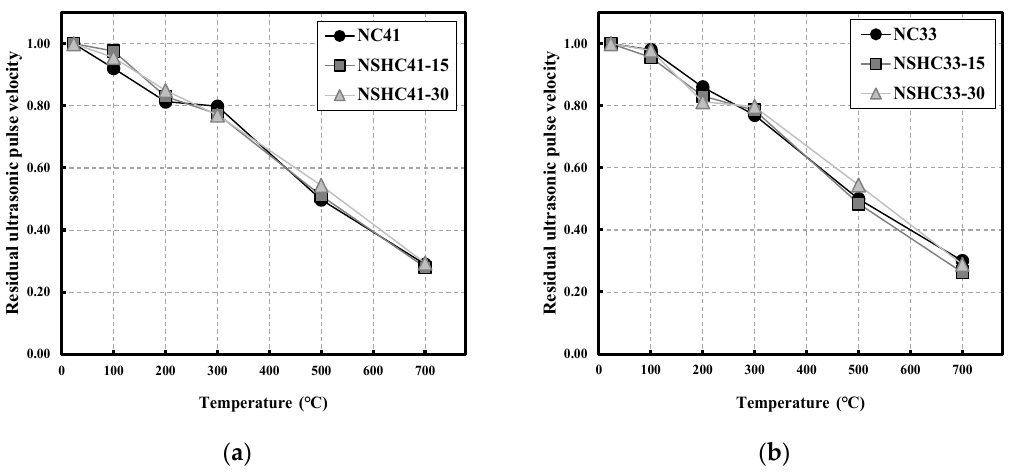
Figure 8. Residual ultrasonic pulse velocity on NC and NSHC after high ‐ temperature exposure: ( a ) W/B 41; ( b ) W/B 33.